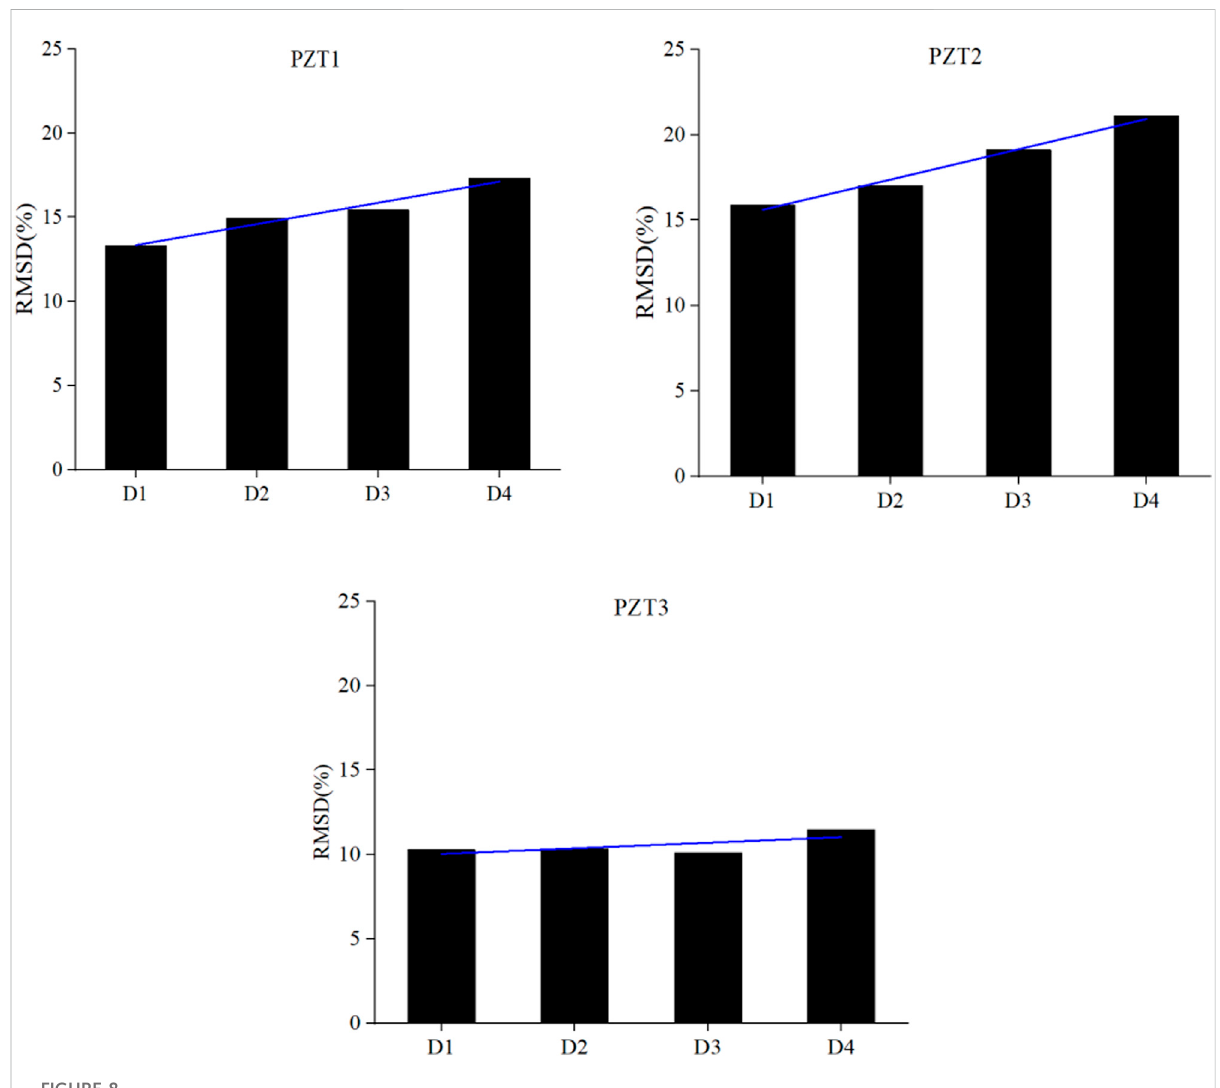
FIGURE 8 RMSD value of the PZT sensors of BE0 with the increase of